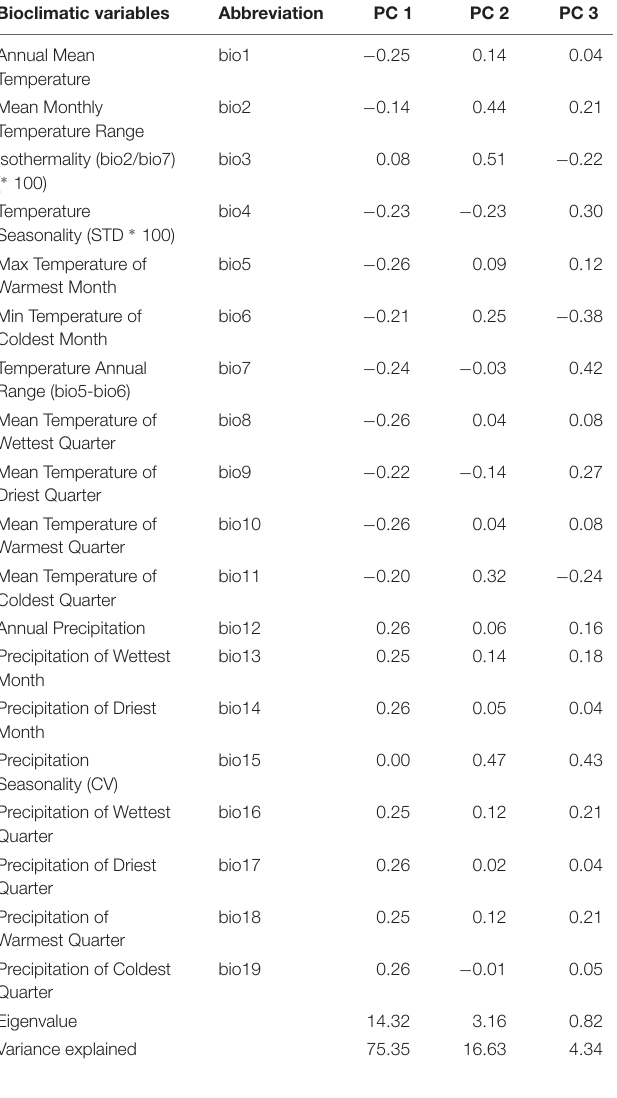
TABLE 1 | Pearson correlation coefficients between climatic variables and the first three major components, eigenvalues and variation explained. Bioclimatic